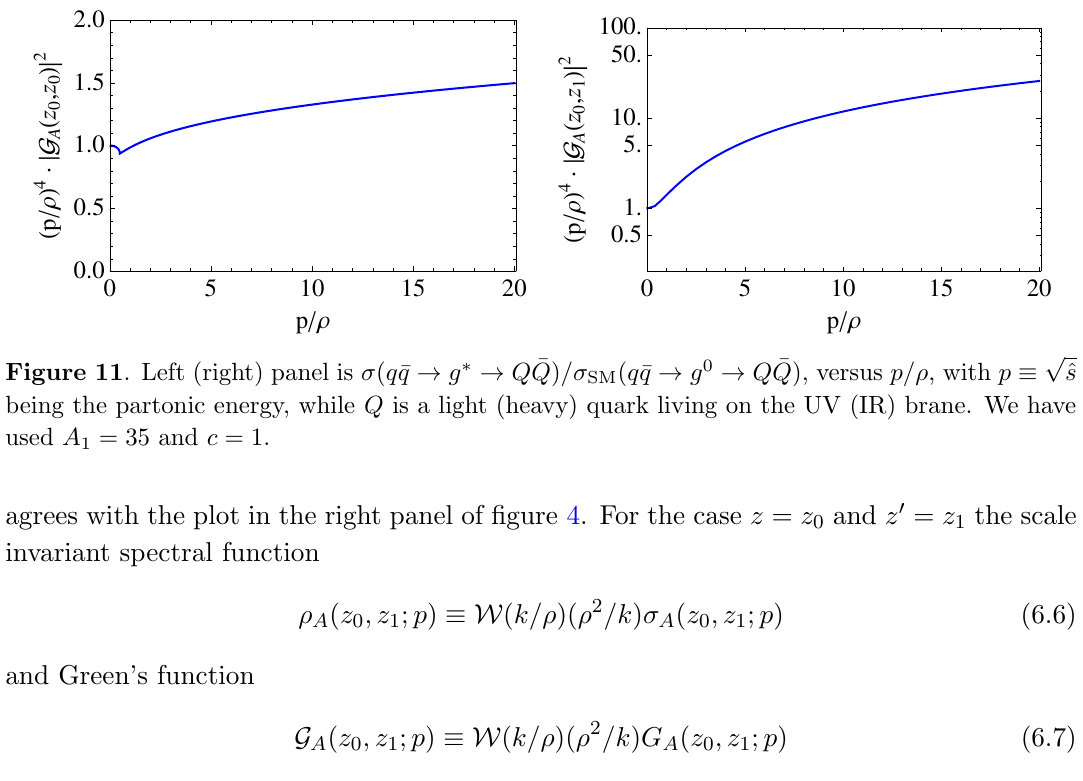
Figure 10 . Scale invariant spectral density (left panel) and squared absolute value of the Green’s function (right panel) for gauge bosons, for the case z = z 0 and z 0 = z 1 . We have used A 1 = 35 and c = 1.